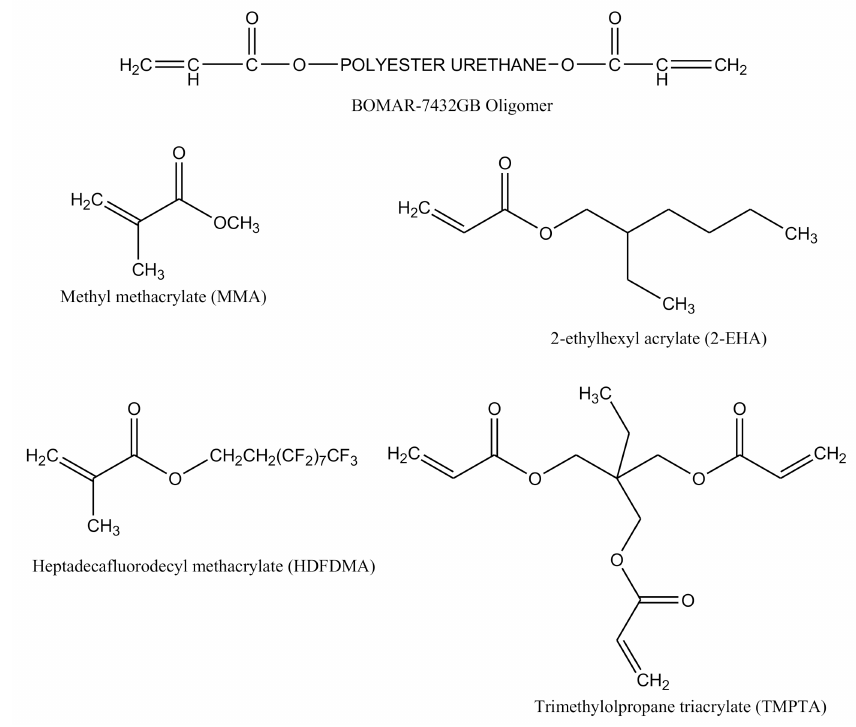
Figure 1. Molecular structure of the oligomer and monomers used. Table 1. Composition of the UV-LED curable